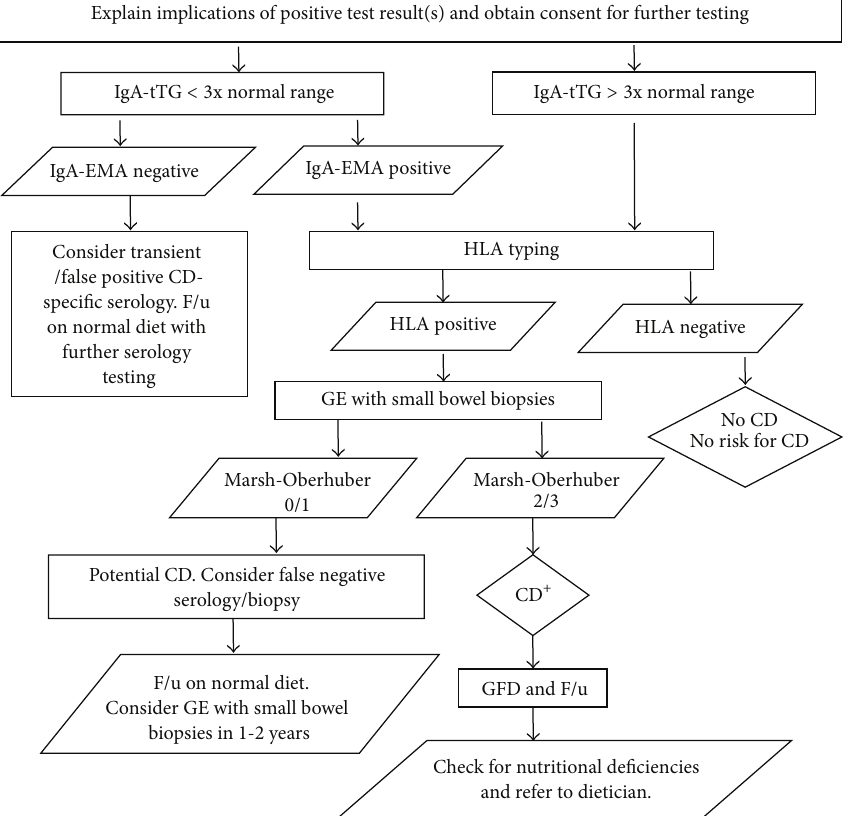
Figure 1: Proposed algorithm for CD diagnosis in asymptomatic individuals with positive CD-specific serology. GE: gastrointestinal endo- scopy, GFD: gluten-free diet, and F/u: